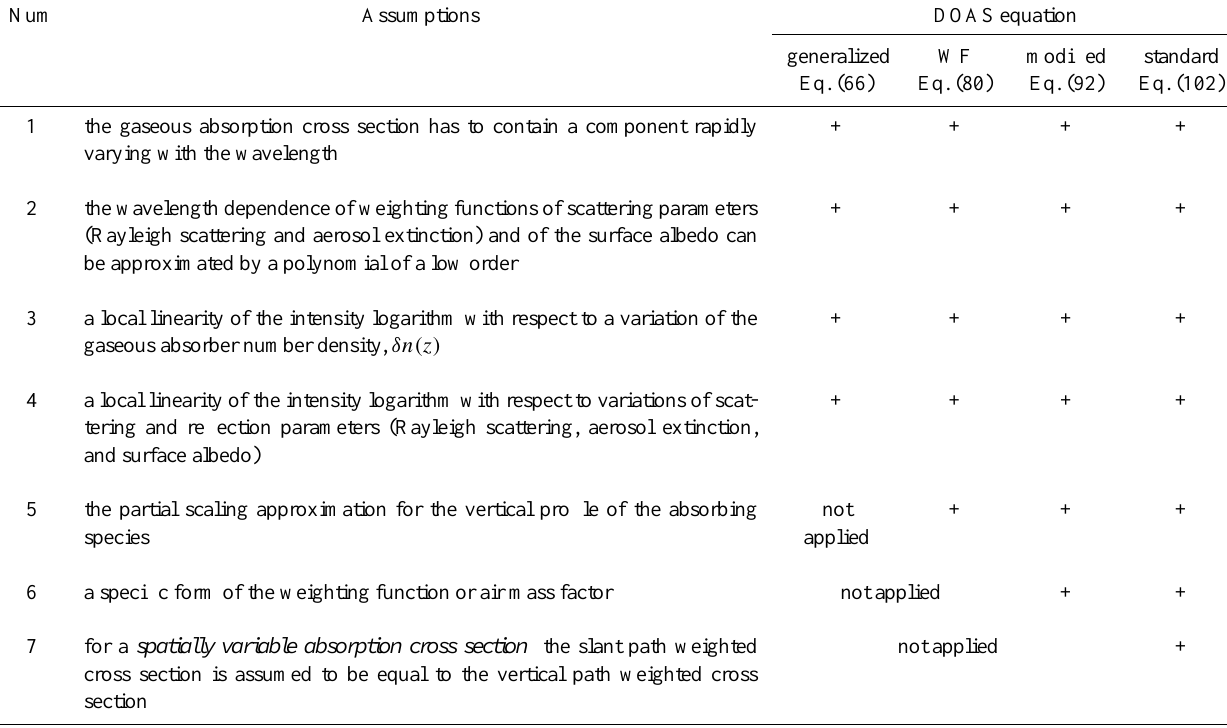
of the symbolic link in the original formulation, Eq.